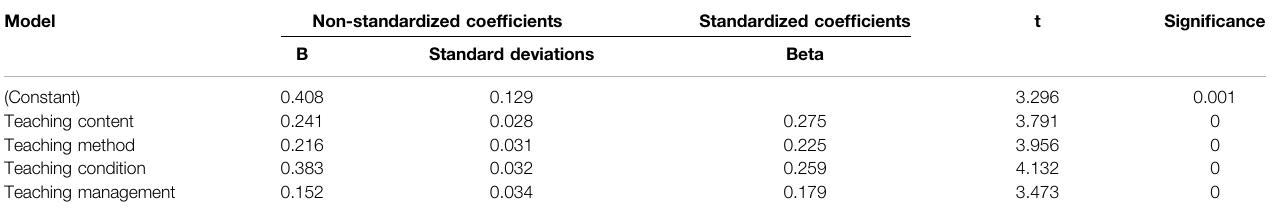
TABLE 8 | Table of regression coef fi cient. Model